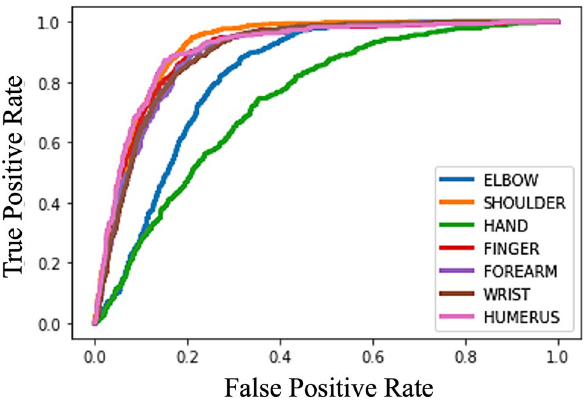
Figure 4. The ROC curves for all body parts on MURA dataset.